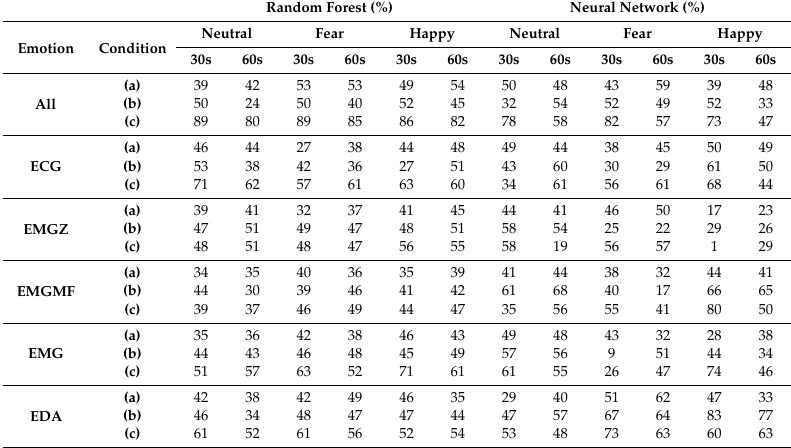
Table 3. F1-score obtained for the two classifiers; (a) corresponds to the subject independent evaluation, (b) corresponds to the subject dependent evaluation, and (c) corresponds to emotion dependent